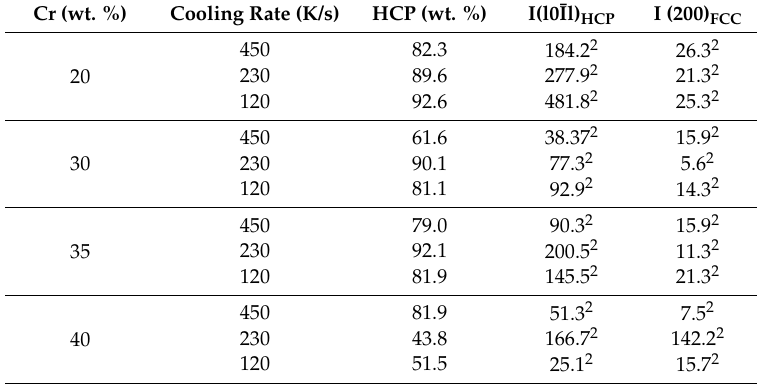
Table 2. Athermal ε -martensite transformation as a function of cooling rates for several Cr contents.